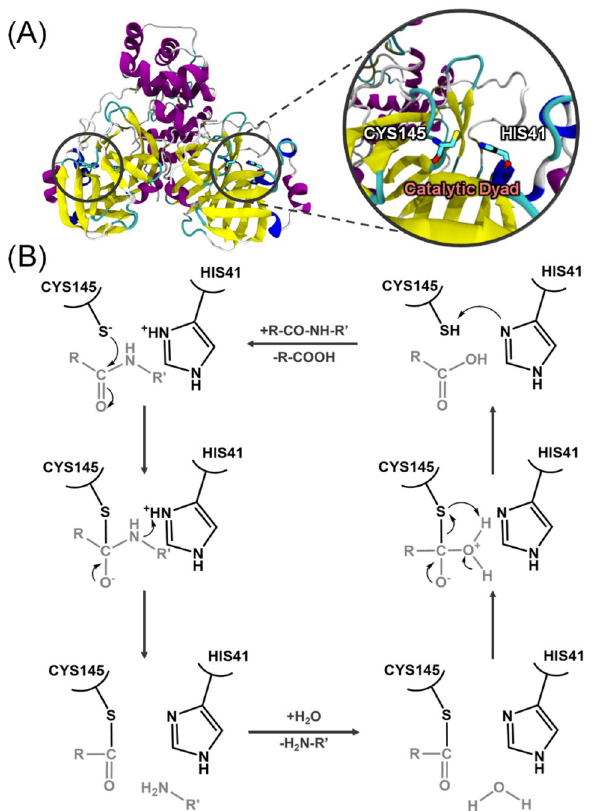
Figure 1. ( A ) Homo-dimeric crystal structure of M PRO (PDB: 6WQF) with a highlight of the catalytic dyad, CYS145, and HIS41. Helices, beta-sheets, turns are colored by purple, yellow, and cyan, respectively. ( B ) Possible reaction mechanism of cysteine